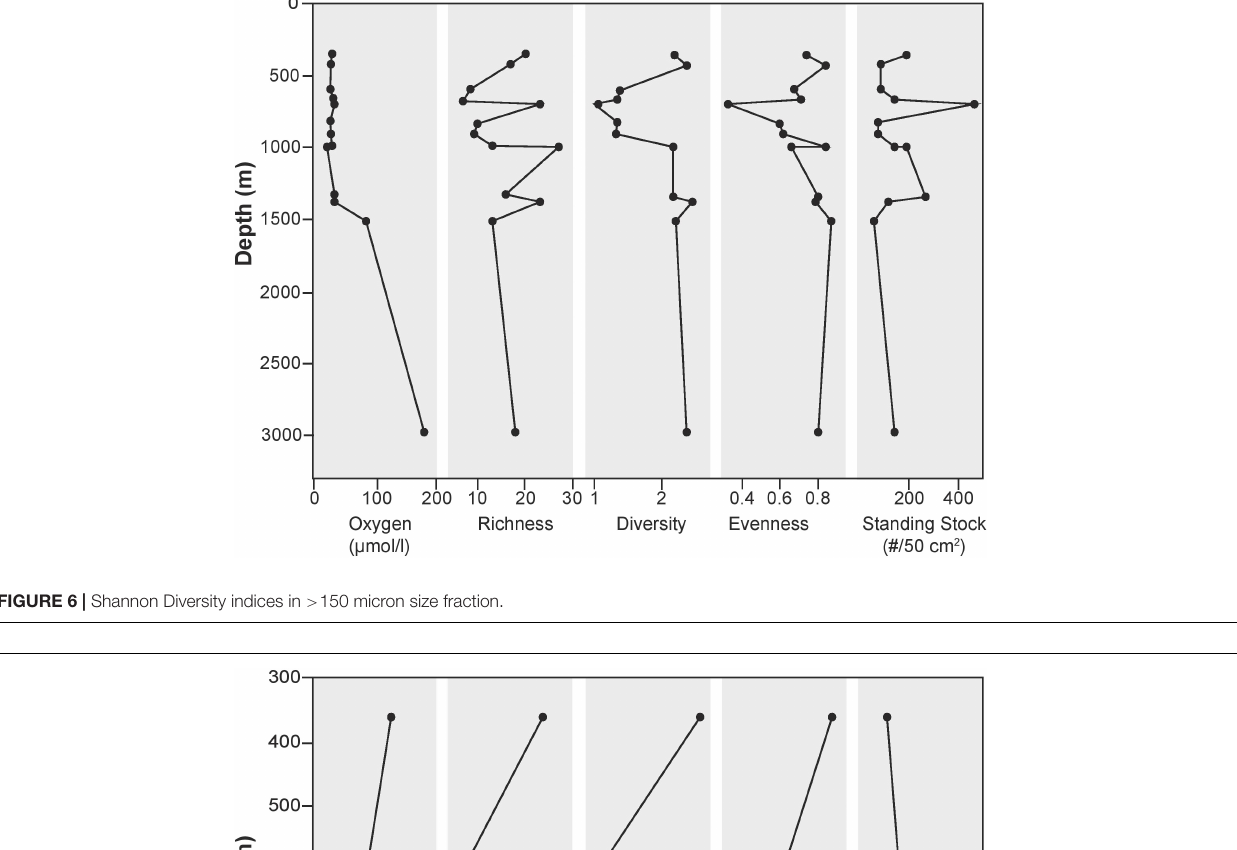
FIGURE 6 | Shannon Diversity indices in > 150 micron size fraction.